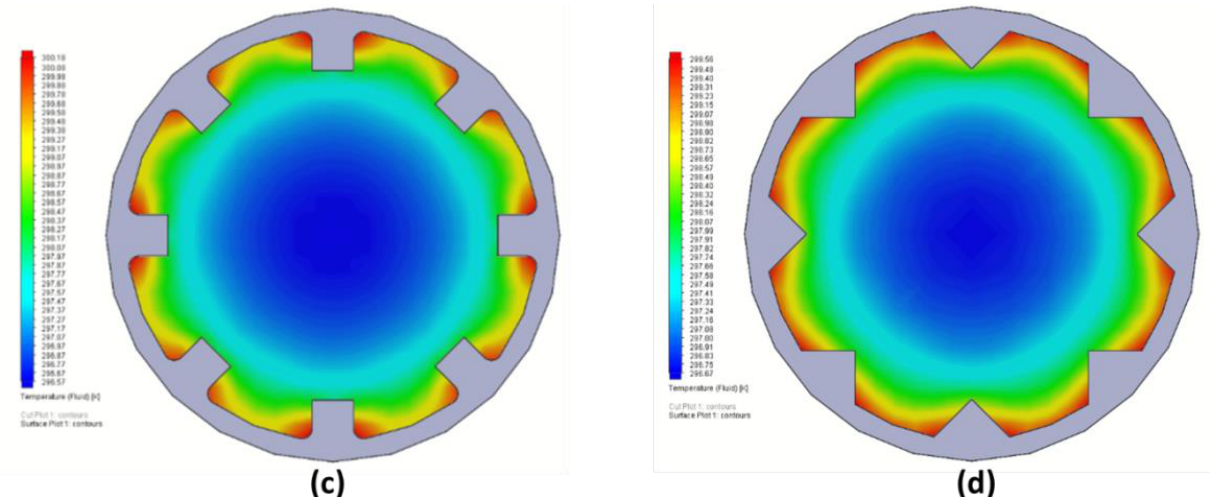
Figure 21. The fluid temperature in the outlet cross-section for the ( a ) reference empty tube [296.67–299.35 K], ( b ) tube with circular fins [296.52–302.75 K], ( c ) tube with rectangular fines [296.57–300.18 K], and ( d ) tube with triangular fins [296.67–299.58 K].